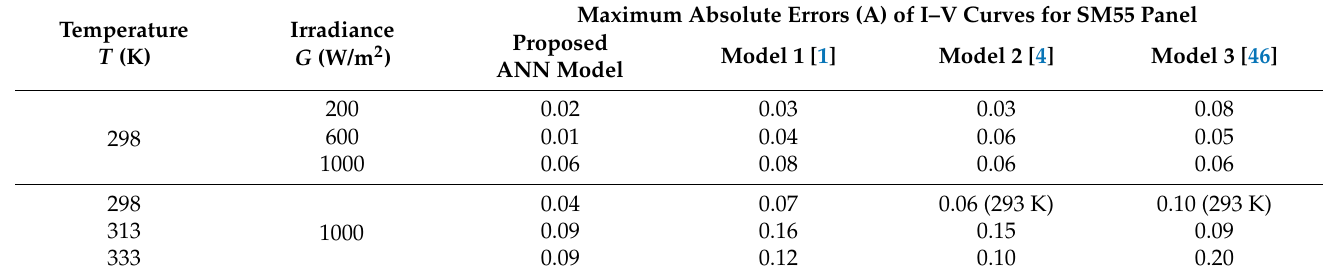
Figure 5. I – V curves and absolute error by simulated and experimental data ( a ) at different irradiances and ( b ) at different temperatures. Table 2. Comparison of maximum absolute errors estimated from different models.